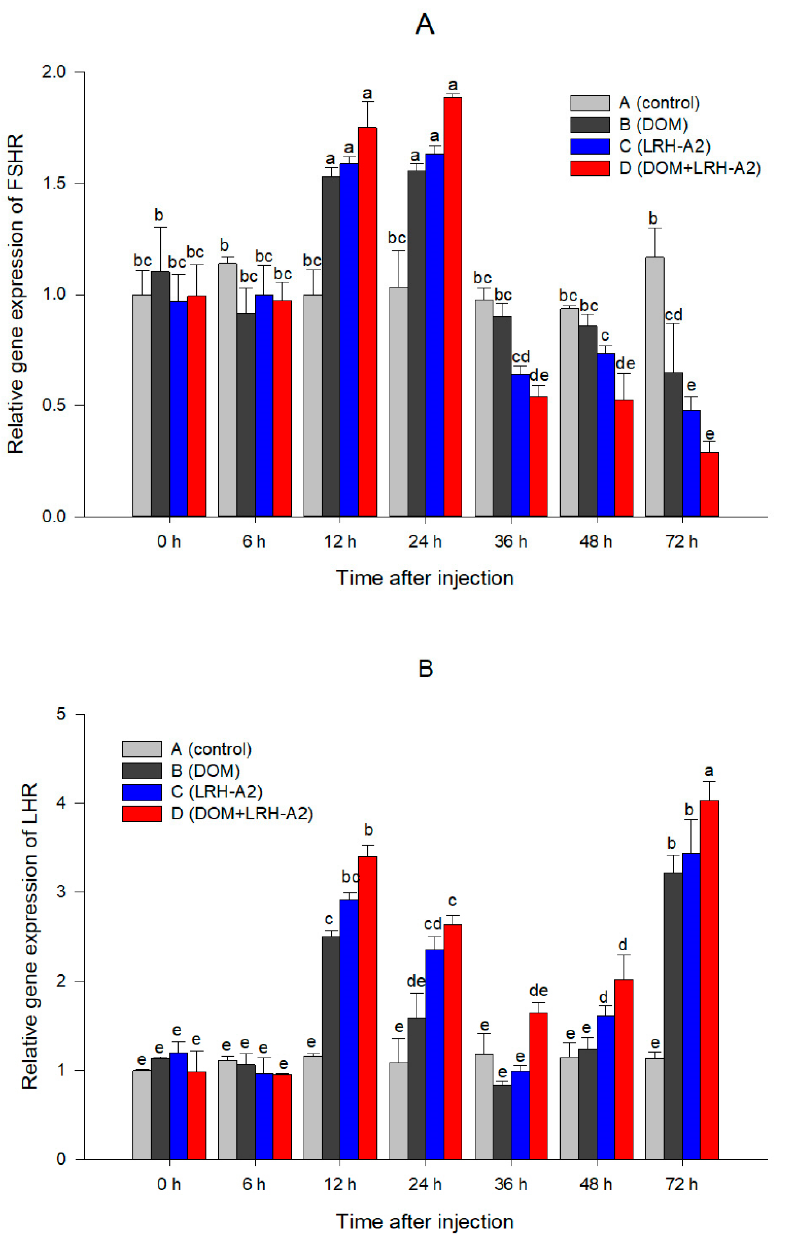
Figure 2. Expression analysis of FSHR gene ( A ) and LHR gene ( B ) in testis after injecting different oxytocins. Note: Different lowercase letters represent significant differences between the experimental groups at various time points ( p < 0.05); Reference gene: β-actin ; n = 3.